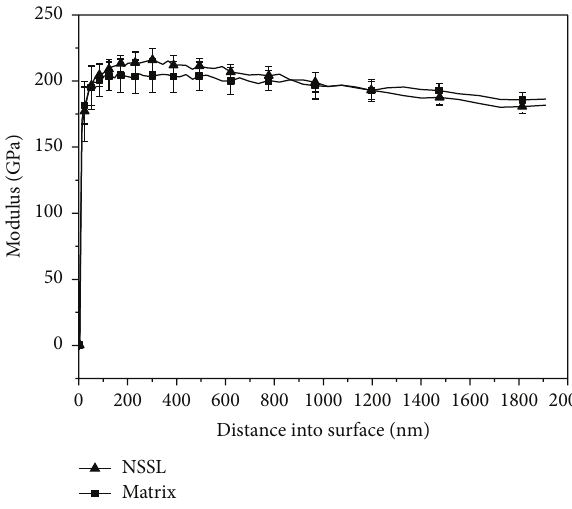
Figure 9: Elastic moduli of the NSSL and the matrix.